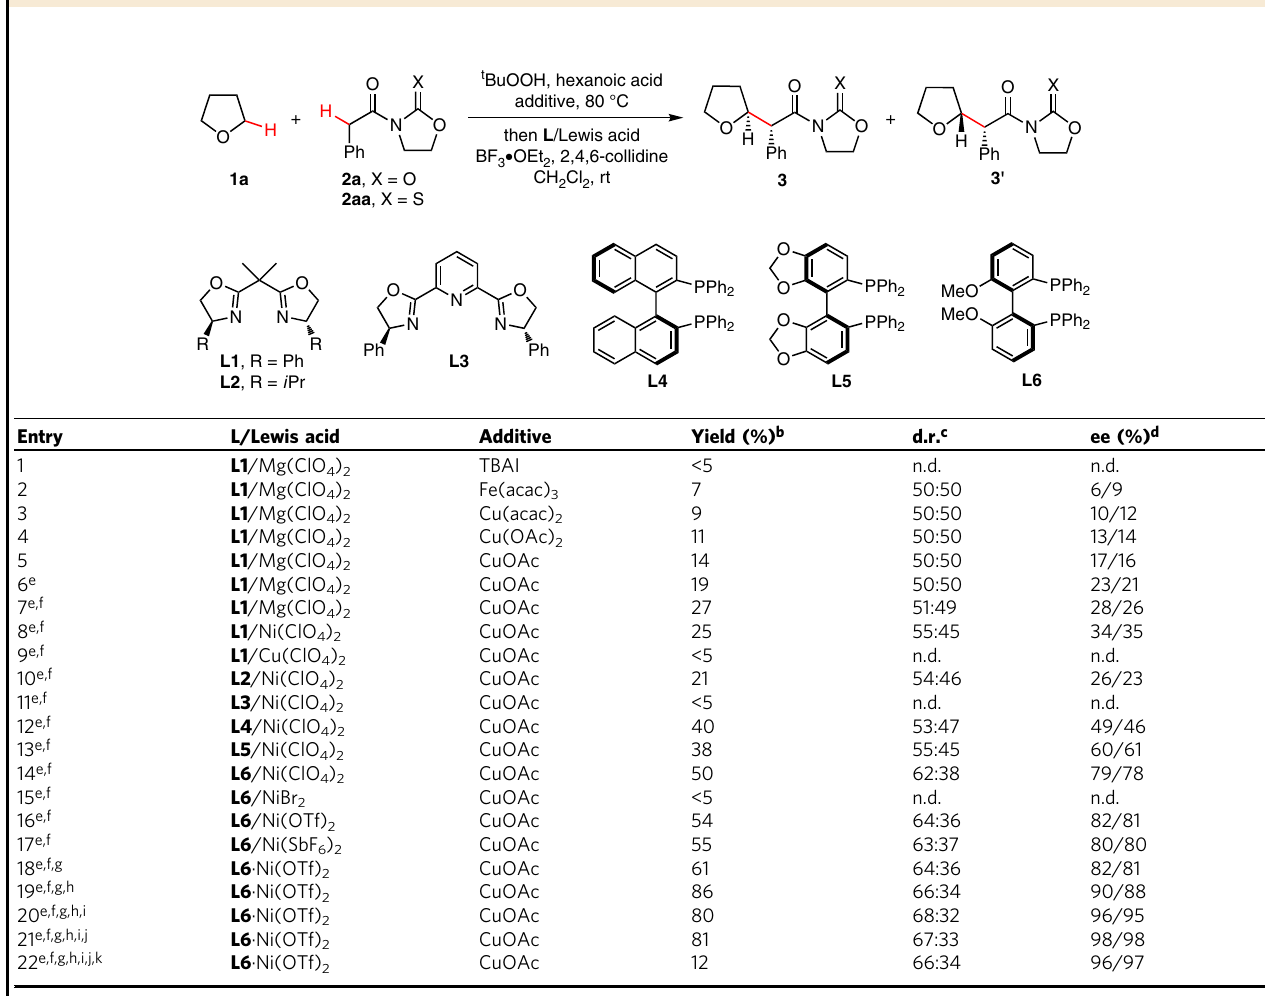
Table 1 Reaction condition optimization